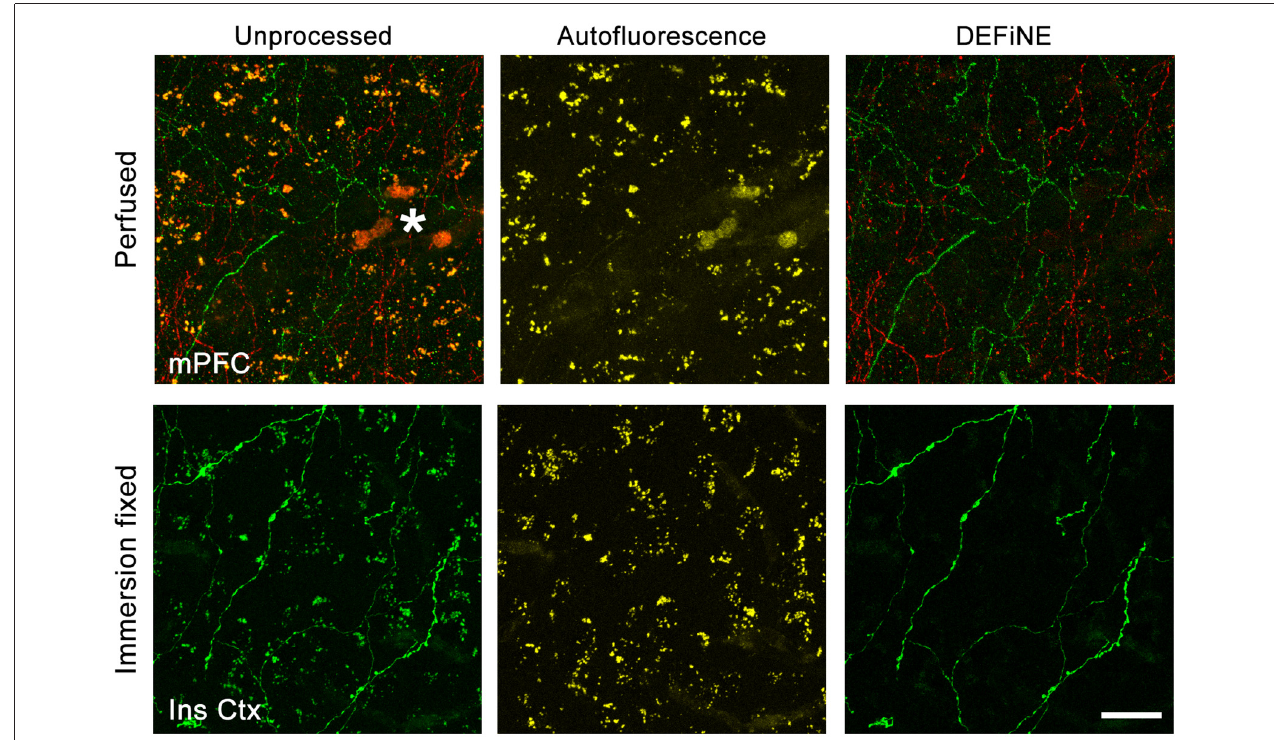
FIGURE 7 | Efficacy of DEFiNE processing does not depend on tissue processing or labeling methods. Results of DEFiNE processing are shown for images collected from tissue fixed by perfusion (top; medial prefrontal cortex, mPFC) or immersion in paraformaldehyde (PFA) solution (bottom; insular cortex, Ins Ctx). The image from perfusion fixed tissue (top) shows noradrenergic axons labeled with Alexa Fluor 488 and Alexa Fluor 568. The image from immersion fixed tissue shows native EGFP fluorescence in noradrenergic neurons expressing the RC::FLTG indicator allele (Plummer et al., 2015). Left, unprocessed images in which axonal fibers are obscured by lipofuscin or autofluorescent red blood cells (*). Center, autofluorescence channels. Right, axonal fibers after DEFiNE processing. Scale bar: 20 µ